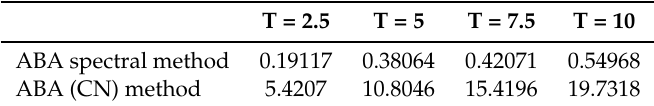
Table 7. Computational times of one soliton in spinor system.